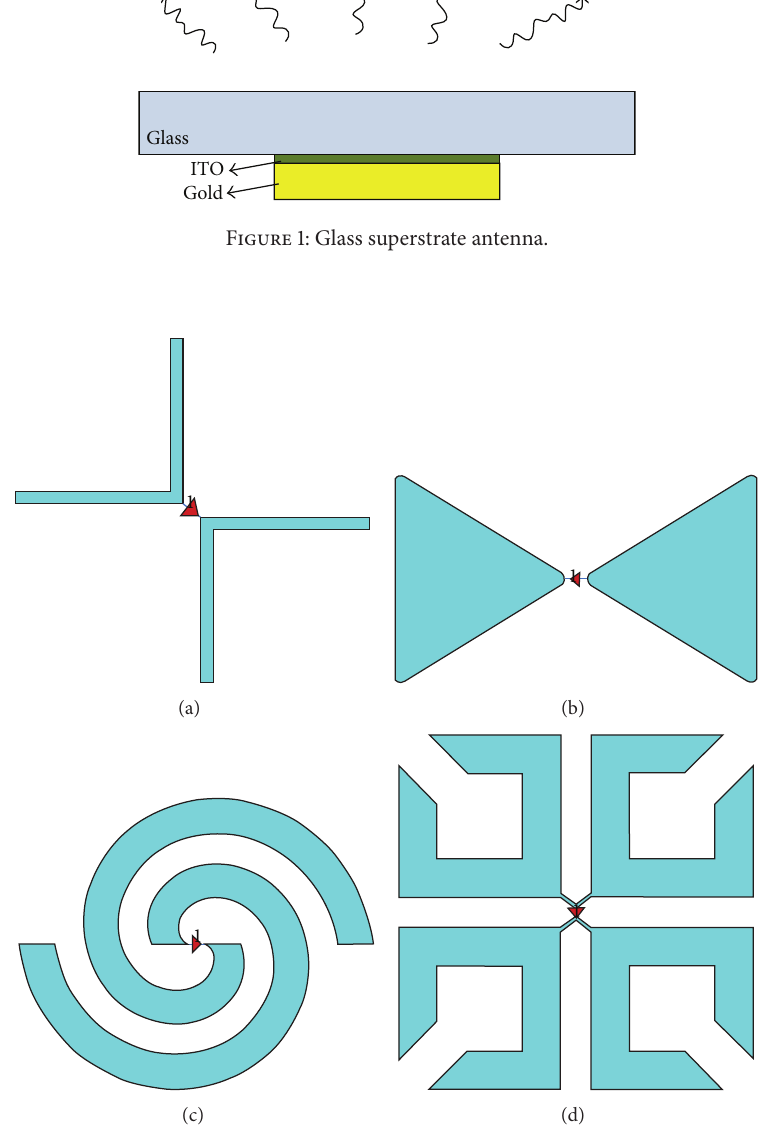
Figure 2: Nanoantenna structures considered for infrared applications, (a) crossed dipole, (b) bowtie, (c) Archimedean spiral, and (d) modified crossed